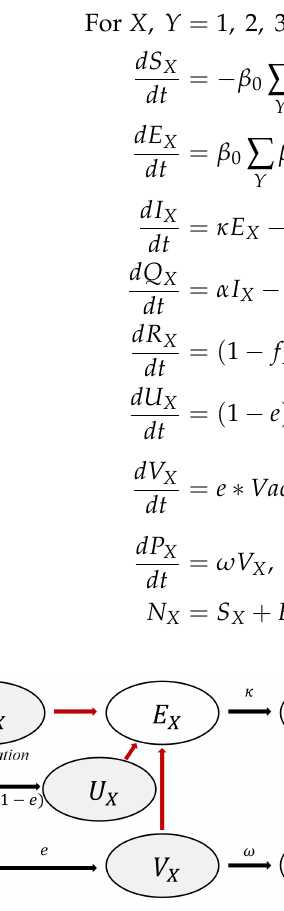
Figure 2. Flow chart of vaccination-applied mathematical